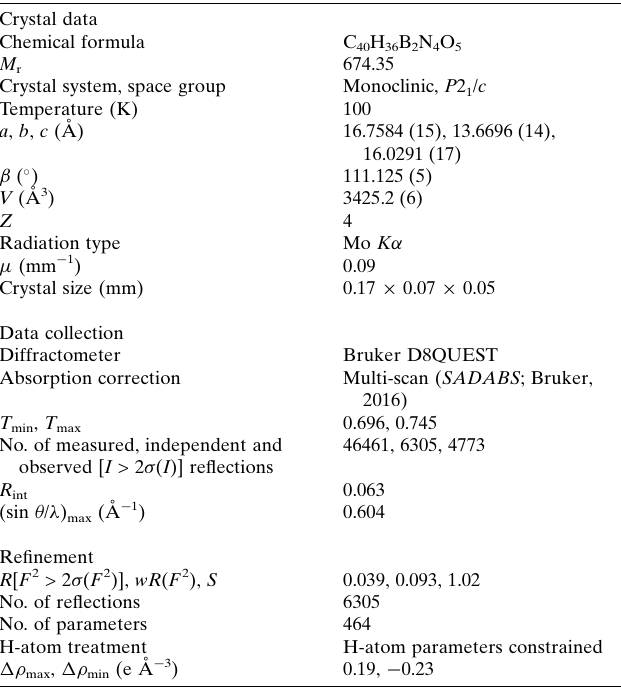
Table 2 Experimental details. Crystal data Chemical